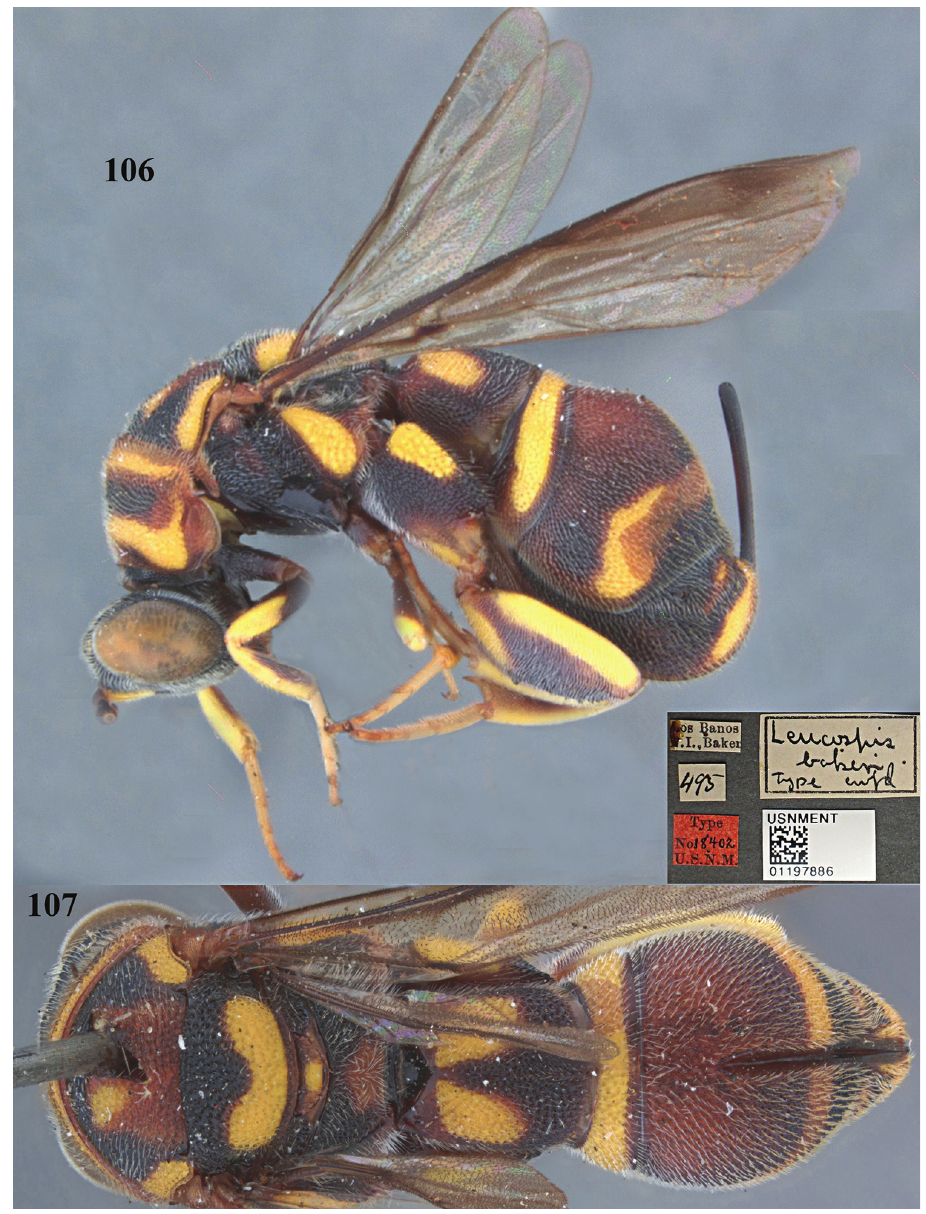
Figures 106, 107. Leucospis bakeri Crawford, ♀ , holotype. 106 Habitus lateral 107 habitus dorsal (courtesy of Dr. Elijah Talamas, Smithsonian Institution, Washington DC,